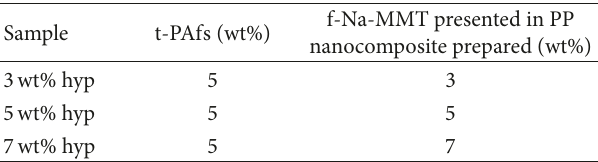
Table 1: Sample designation and composition of hybrid